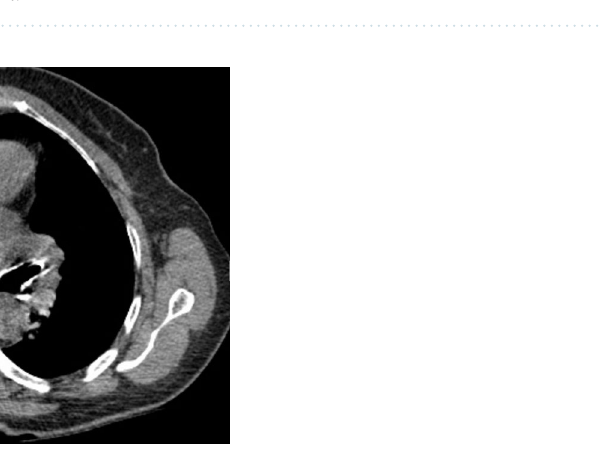
Figure 5. In this 67 y/o man with severe anemia, both aortic ring sign (arrow in ( a )) and interventricular septum sign (arrow in ( b )) were present.